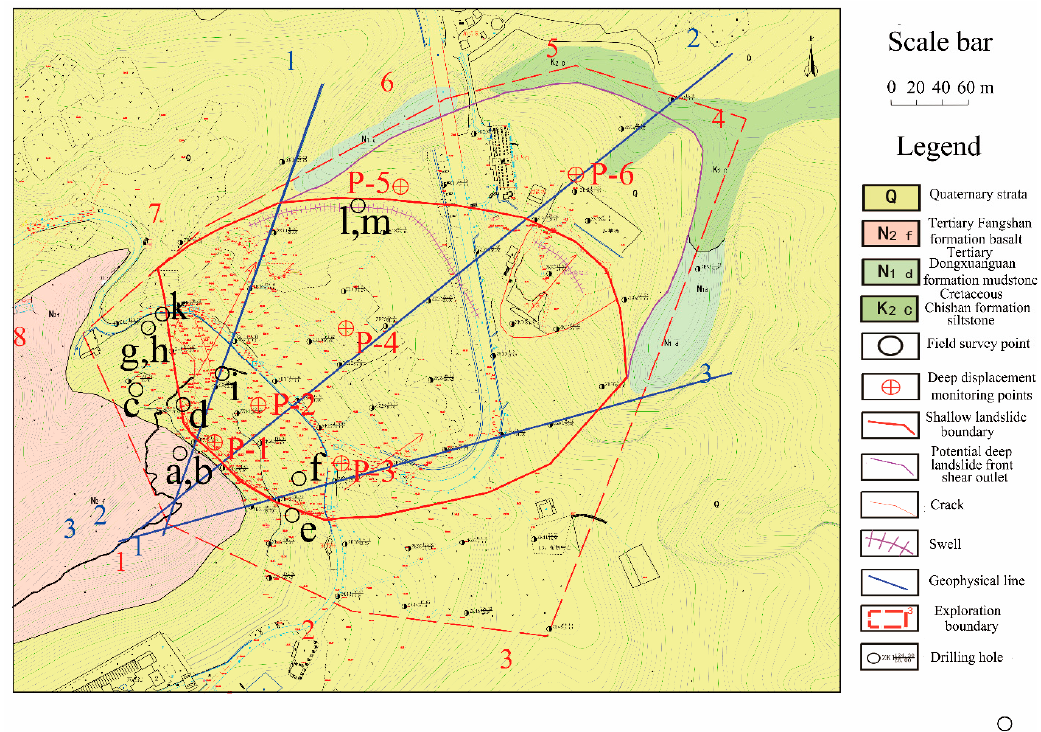
Figure 5. Investigation results of the Fangshan landslide, which shows the distribution of layers on the surface ground, the results of the field surface survey, the location of P1–P6 deep monitoring points and the geophysical line. Numbers 1–8 indicated the field investigation area.